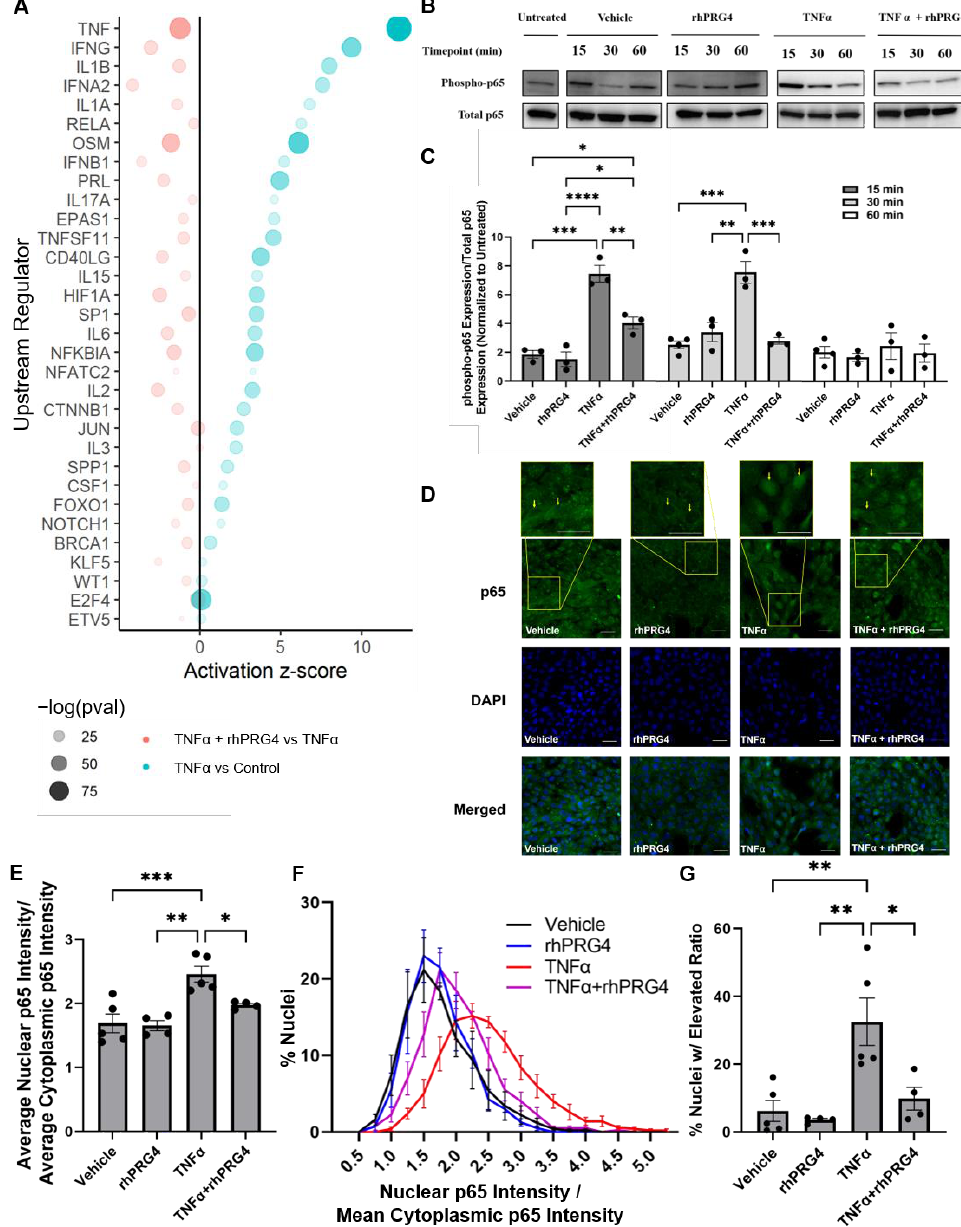
Figure 2. The effect of rhPRG4 on upstream regulators stimulated by TNF α , specifically nuclear factor kappa B (NF κ B). ( A ) Upstream regulators that were activated by TNF α treatment, and down-regulated thereafter on the addition of rhPRG4. Size and shading correspond to the statistical significance ( p